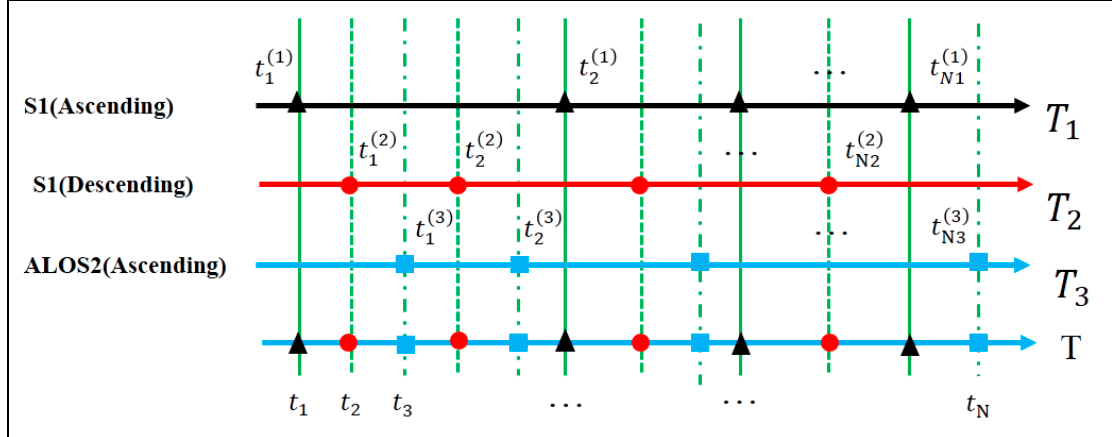
Figure 5. Time series of Sentinel-1 ascending and descending data, and ALOS2 ascending data.